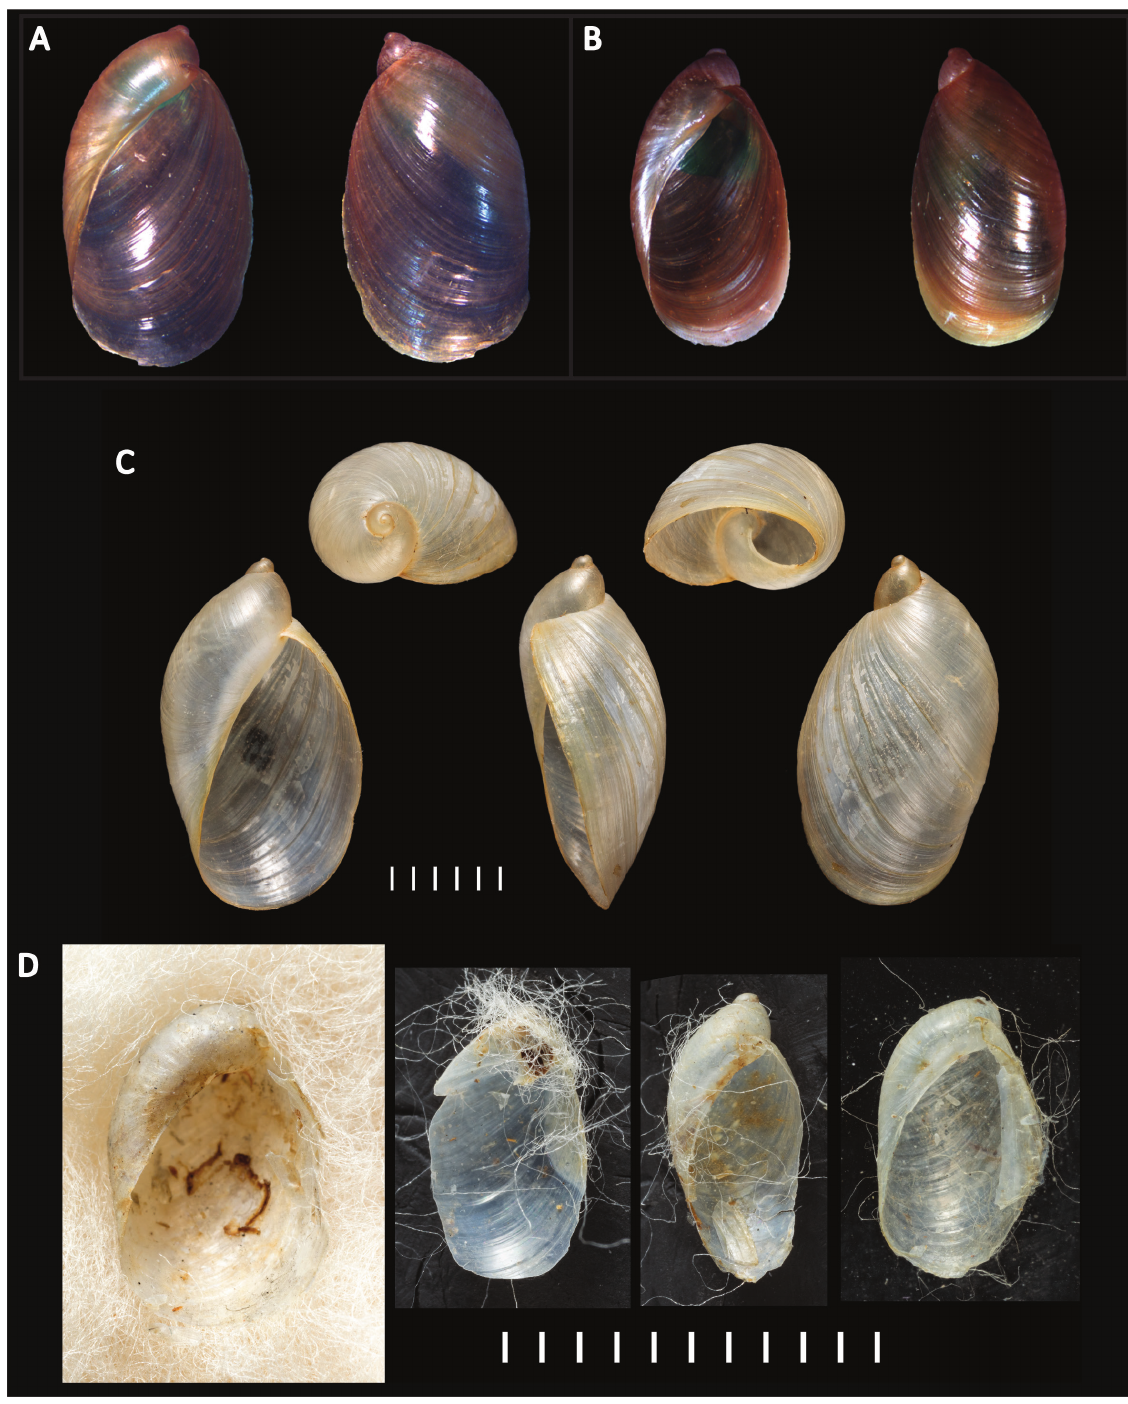
Fig. 5. Apertural and reverse view of shell of Oxyloma salleanum (L. Pfeiffer, 1850) and O. effusum (L. Pfeiffer, 1853). A . Photograph of Oxyloma effusum shell taken from the type locality in eastern Florida. Shell is 11.28 mm total height. B . Photograph of Oxyloma salleanum shell taken from the type locality near New Orleans, Louisiana. Shell is 13.11 mm total height. C . Syntypes of Oxyloma salleanum (NHMUK # 20170302). D . Syntypes of Oxyloma effusum (NHMUK # 20170303). Scale bars = 1